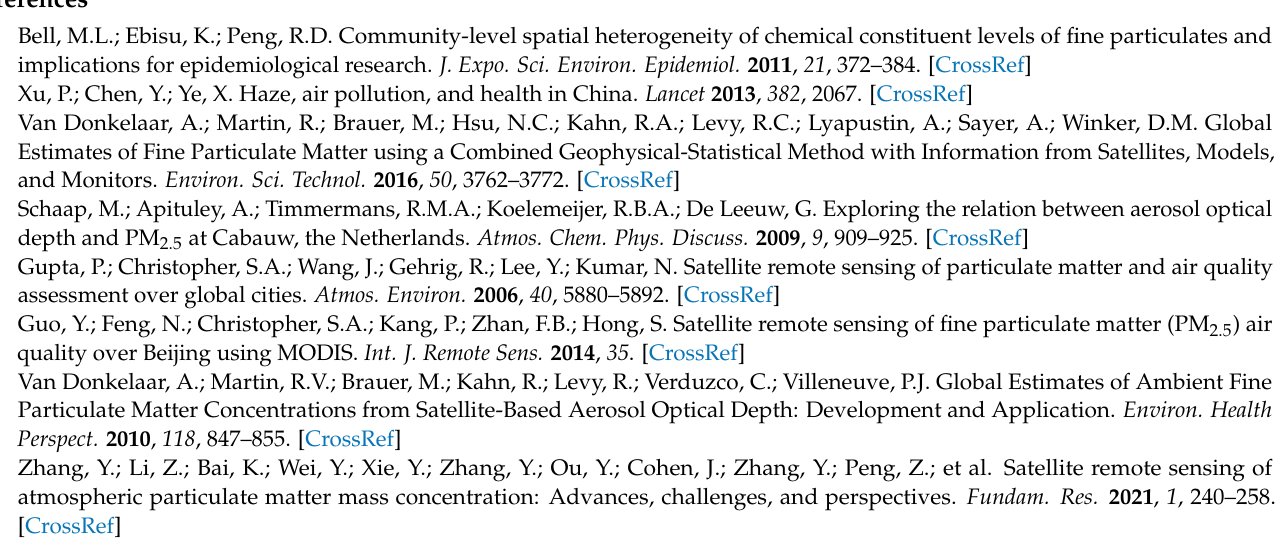
(b,d) for V3.0 FMF; Figure S6. Density scatter plots of modeling results of ground-based PM 2.5 retrieved by four machine learning models (Extratree, Random Forest, LightGBM and XGBoost) based on four different FMF products (Himawari-8 V2.1 and V3.0 FMF, MODIS and VIIRS FMF) with the same lengths for training and test datasets. The black and red lines represent 1:1 and fitting lines, respectively. Because the amount of training data is small (N = 1321), which is unsuitable for applying deep learning models, EntityDenseNet was not used for PM 2.5 estimations here. Table S1. Previous studies of machine learning retrieved PM 2.5 since 2014. Table S2. AERONET stations and their data level used in this study. Table S3. The parameters for the four machine learning models used in this study. Table S4. The class types and their abbreviations of global climate zone. Table S5. The evaluation of MODIS, VIIRS and Himawari-8 V2.1 and V3.0 FMF against the AERONET stations mainland